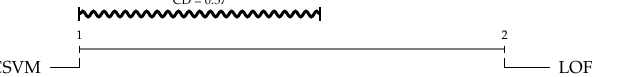
Figure 8. Critical Difference chart of Precision performance between LOF and OCSVM across all attack patterns and magnitudes ( (cid:101) ). It is possible to observe that there is no link between the first and second techniques, which demonstrates some significant difference between OCSVM and LOF, with OCSVM as the superior